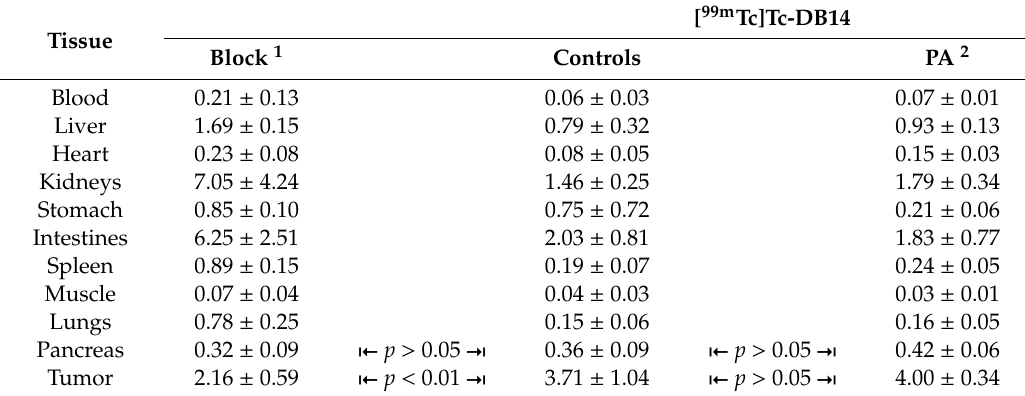
Table 2. Biodistribution data for [ 99m Tc]Tc-DB13, expressed as %IA/g mean ± SD, n = 4, in PC-3 xenograft-bearing SCID mice at 4 h pi.